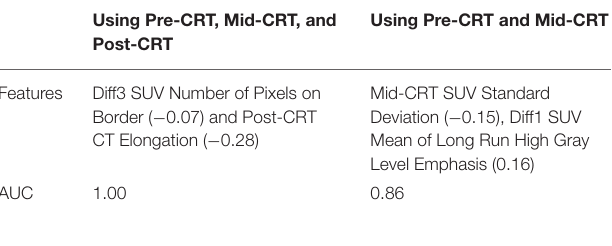
Using Pre-CRT and Mid-CRT